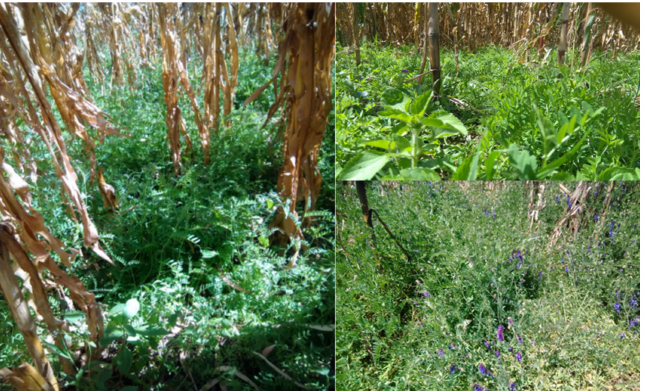
Figure 1. Planting hairy Vetch ( Vicia vilosa ) under maize crops after maize tasseling or 2 months before harvesting, in